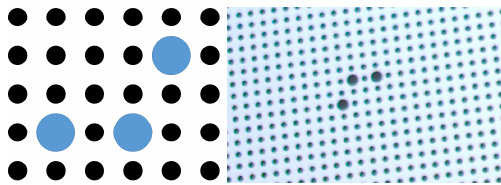
Figure 2. AIT’s dot pattern calibration target with 3-dot central element ( left : abstract representation, right : actual acquisition with one of EBCA’s caneras). Note that this pattern is the smallest possible asymmetric configuration on a regular grid and three distinct marks (the different color is for illustration only) suffice to estimate an affine transformation, which approximates the more general perspective transformation needed to unwarp the image, c.f. [46] for